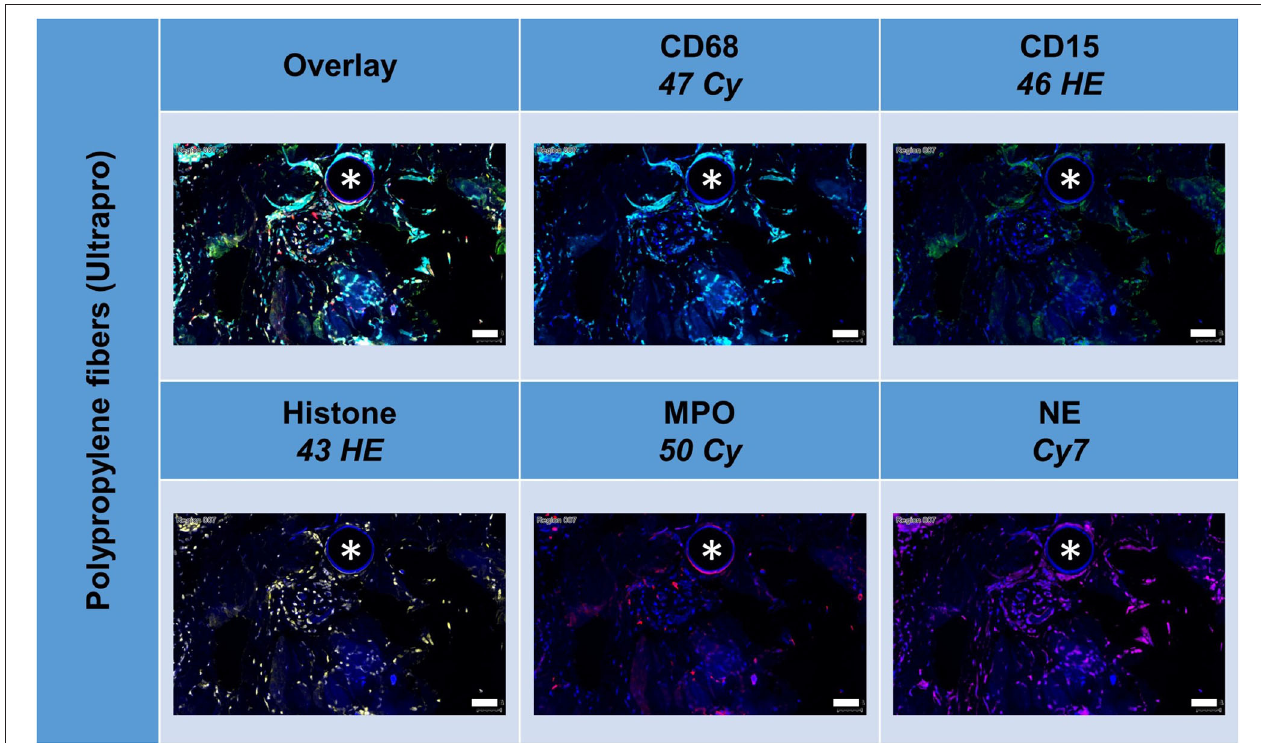
FIGURE 6 | Example of mesh-tissue section stained with neutrophil panel. Labeling for nuclei with DAPI (blue), macrophages with CD68 (turquoise), neutrophils with CD15 (green), histone (yellow), myeloperoxidase (MPO, red), and neutrophil elastase (NE, magenta). Asterisk marks a fiber location, scale bars = 50 µ